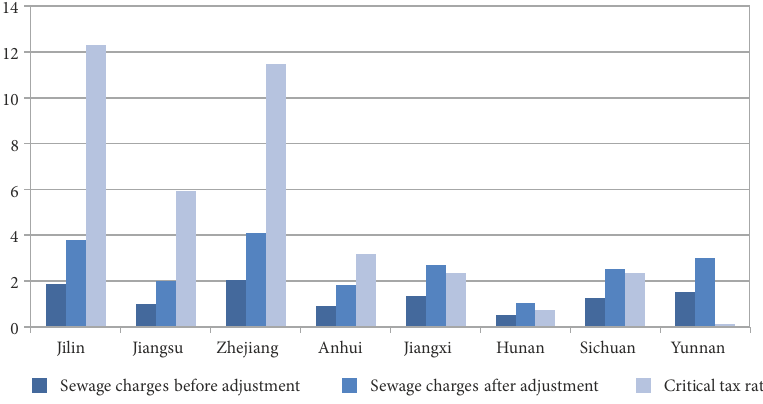
Figure 11. Sewage charges before and after the adjustment